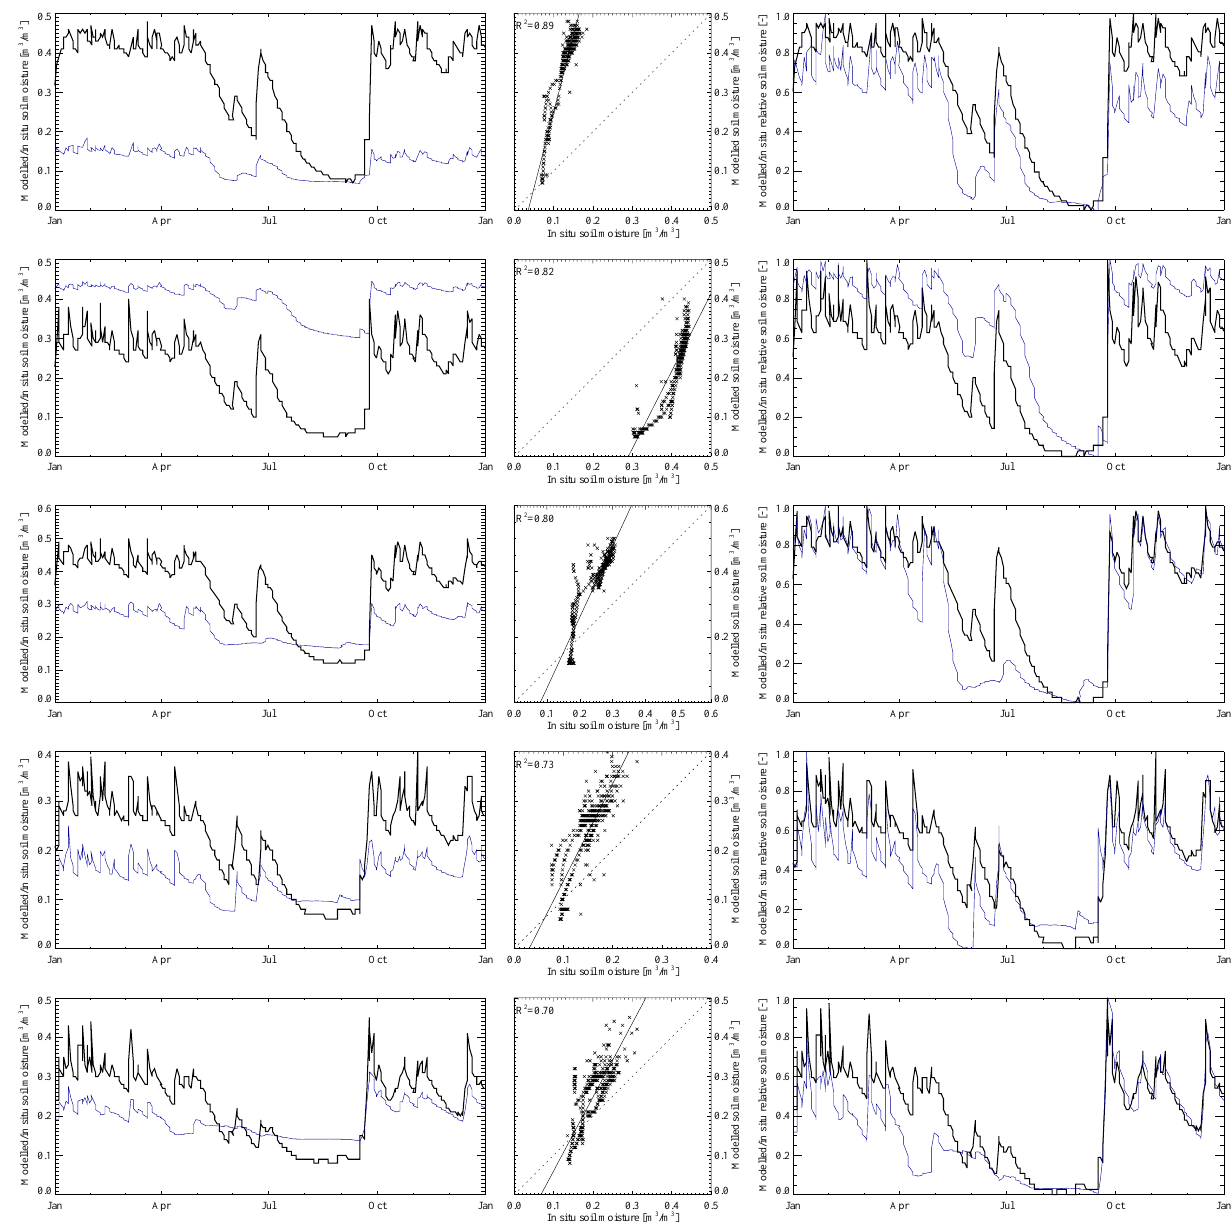
Fig. 2. Validation of modelled soil moisture over 30cm depth at (from top to bottom) Fitterizzi, Mongrassano, Torano, Chiaravalle and Satriano in situ stations (see corresponding annotations in Fig. 1). Left column: modelled (thick line) and in situ (blue line) volumetric soil moisture content during the year 2009. Middle column: scatterplot of in situ and modelled soil moisture for the same period. Right column: modelled (thick line) and in situ (blue line) relative soil moisture during the same